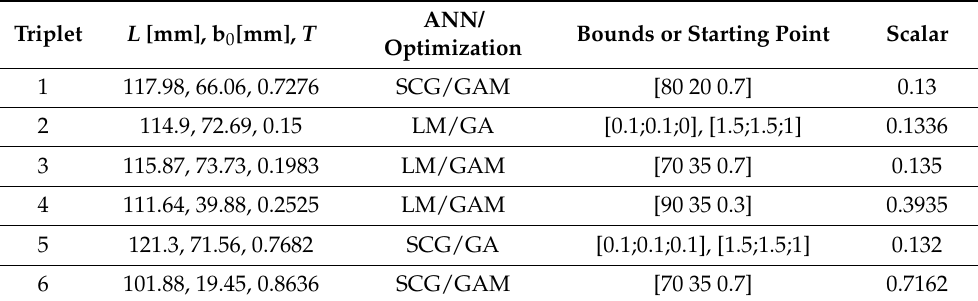
Table 4. List of optimal dimensions as obtained per different methods. GA stands for the genetic algorithm and its upper and lower bounds, starting point is related to the goal attainment method (GAM). Notation is as per Table 1 and T denotes tapering ratio.